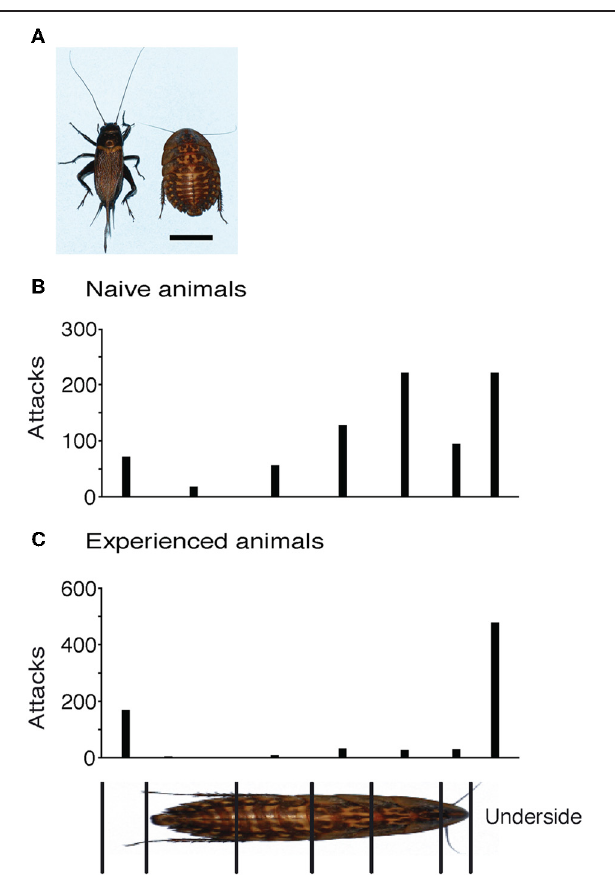
FIGURE 5 | Effect of experience with novel prey. (A) Cricket and giant roach differ in shape strikingly. The bottom right scale bar equals 1cm. (B) Attack histogram of Naïve animals showing 67% of all attacks on the body. (C) Attack histogram of experienced animals showing a change in attack strategy with only 14% attacks on the